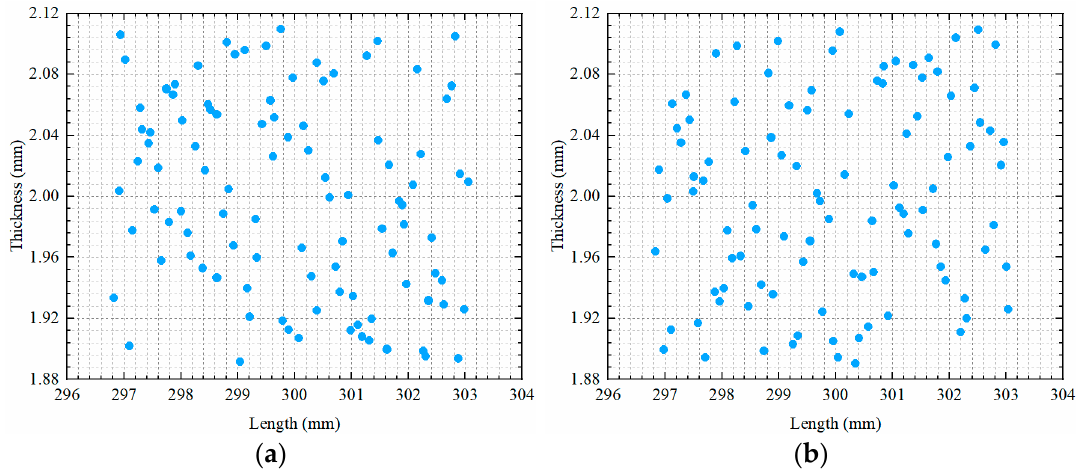
Figure 11. Distribution of LHS samples. ( a ) First model-updating approach and ( b ) second model- updating approach.